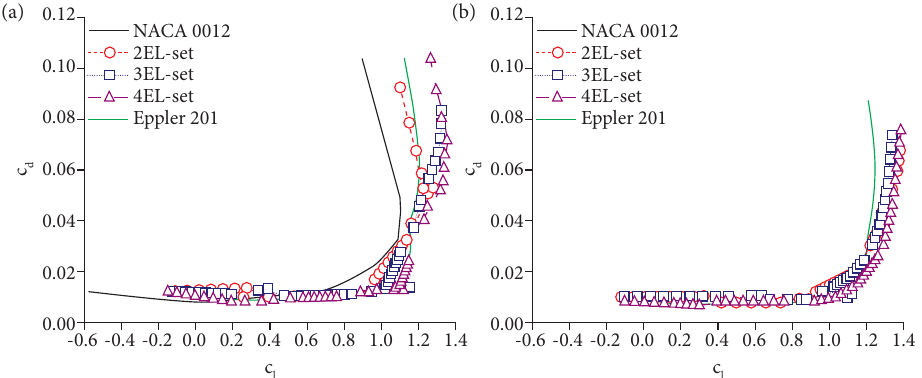
Figure 8. Drag polar of morphed airfoil groups with target airfoil. (a) Re = 2.5 × 10 5 ; (b) Re = 4.8 × 10 5